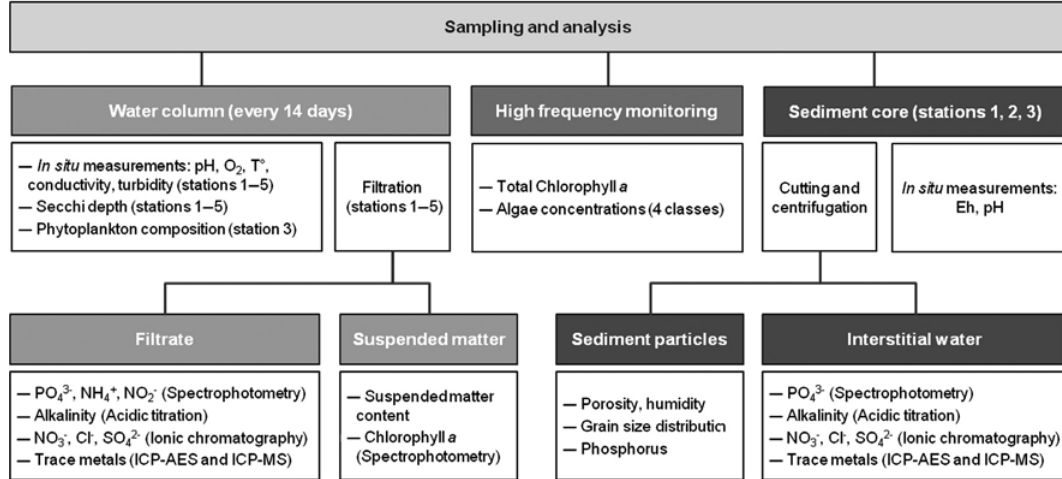
Fig. 2. Sampling and analysis design for water, sediment and